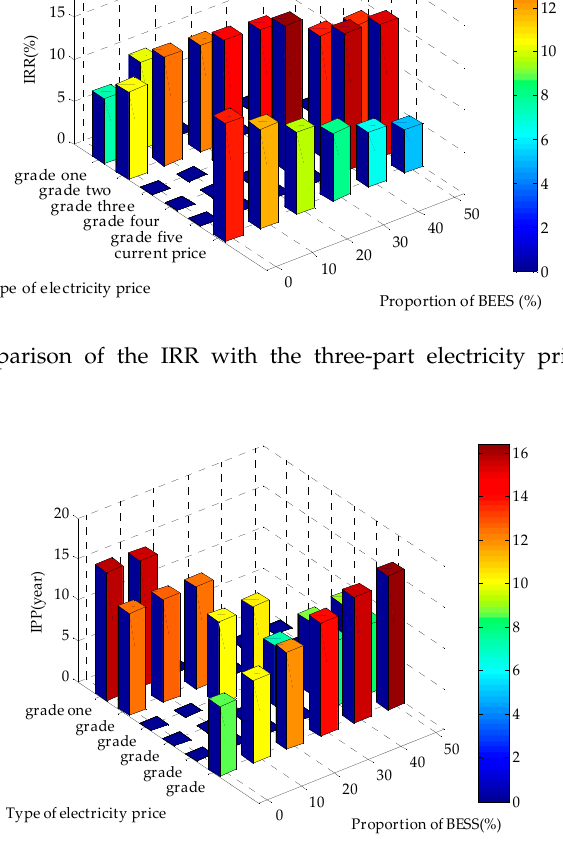
Figure 13. The comparison of the IPP with the three-part electricity price and the current stake electrovalence.